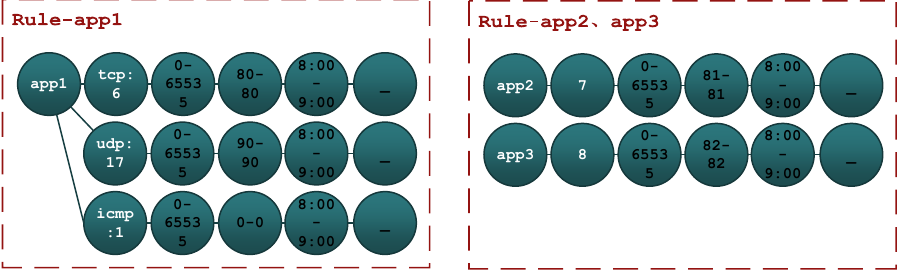
Figure 6. Transform from relationship to application match